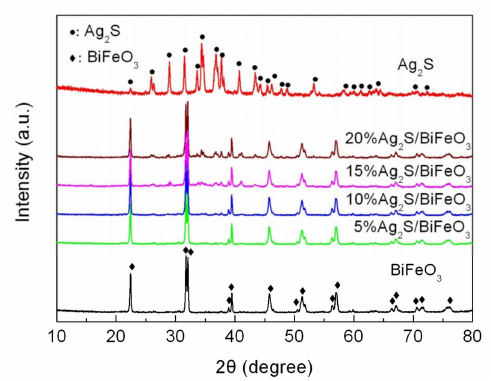
Figure 1. X-ray powder diffraction (XRD) patterns of BiFeO 3 , Ag 2 S, and Ag 2 S/BiFeO 3 composites.